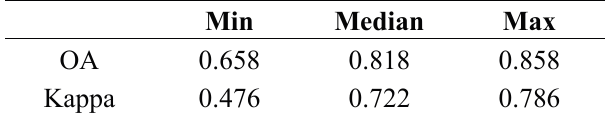
Table 5. Descriptive statistics regarding the overall accuracy (OA) and Kappa coefficient for 1025 segmentation and classifications (OOB results combining samples A and B).